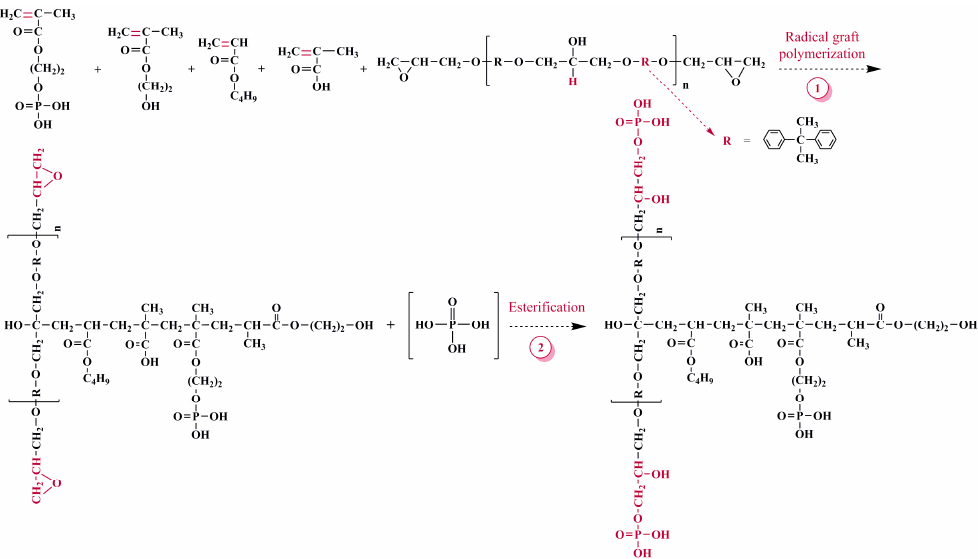
Figure 3. Synthesis route of phosphorus modified poly-acrylic resin.